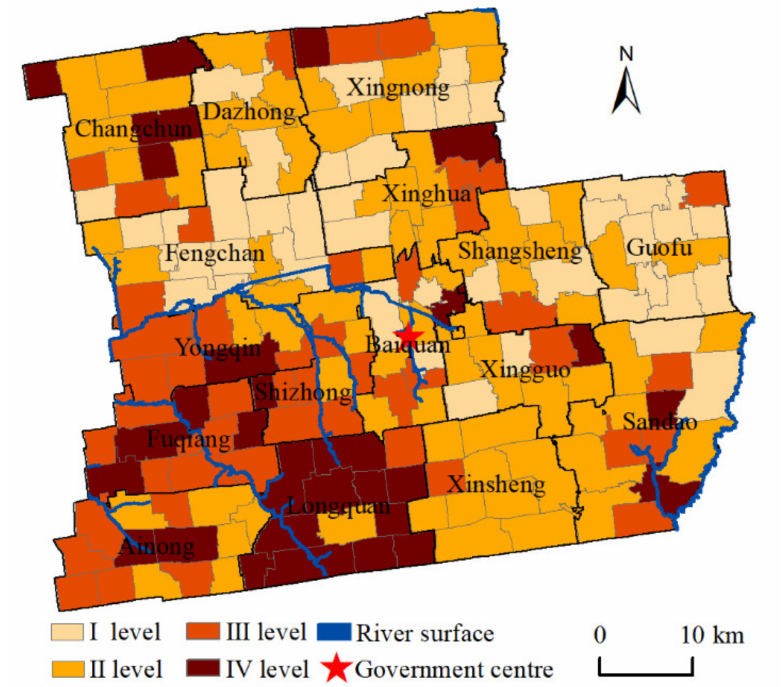
Figure 6. Distribution of the output level of cultivated land